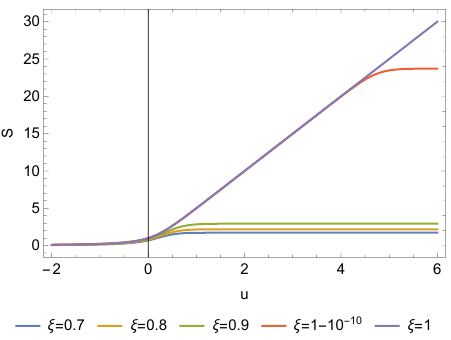
Figure 3 . Plot of von Neumann entanglement entropy, S ( u ) = (cid:0) (1 = 12) log p 0 ( u ), for the class of mirror trajectories eq. (1.6) with (cid:12)nal drifting speeds (cid:24) . Notice the asymptotic divergent entropy for the horizon case (cid:24) = 1, which is in qualitative agreement with results of (cid:12)gure 2, suggesting non-unitary evolution -information loss in the horizon system is responsible for the divergence in